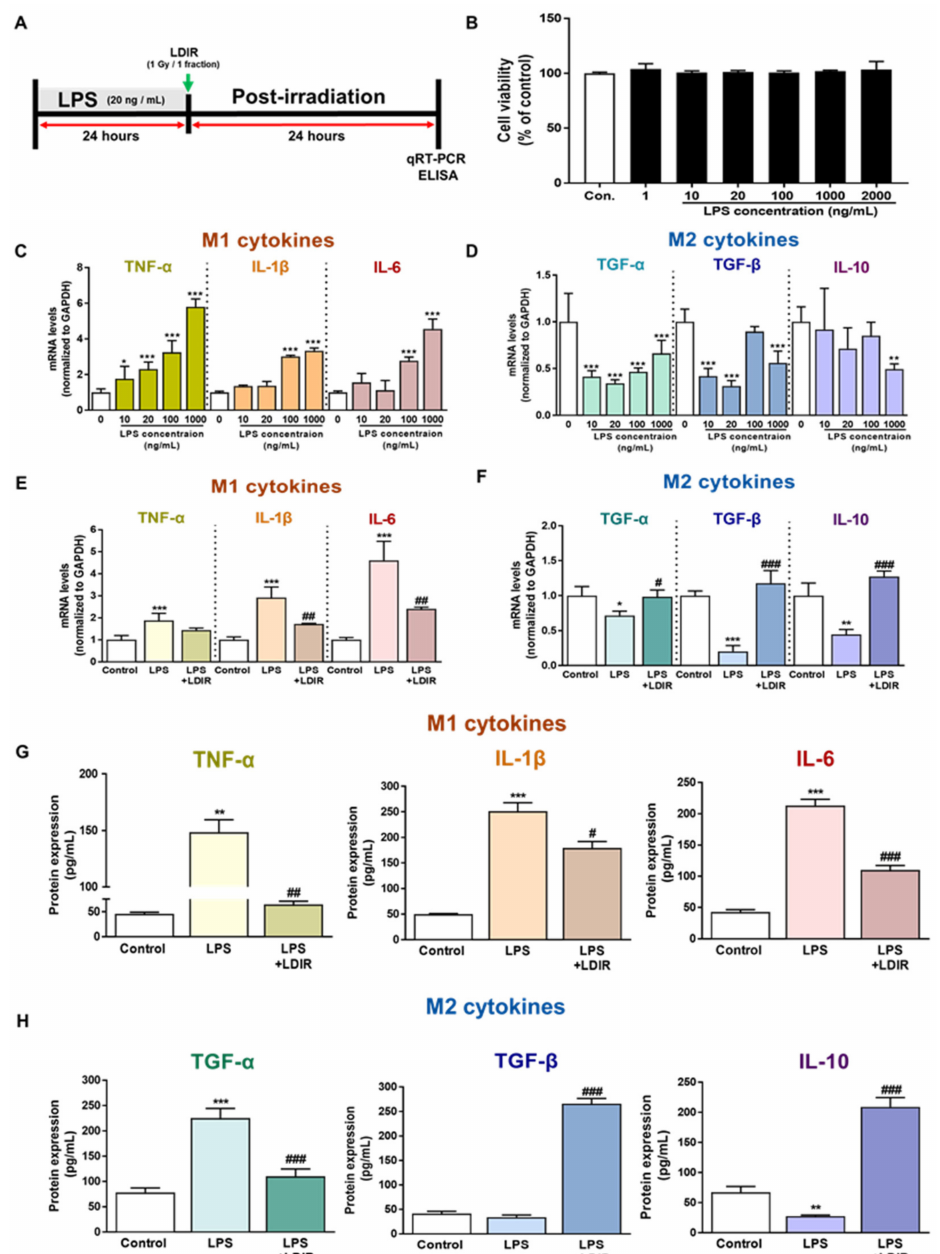
Figure 3. The modulatory e ff ects of LDIR on production and secretion of M1 cytokines (TNF- α , IL-1 β and IL-6) and M2 cytokines (TGF- α , TGF- β and IL-10) in lipopolysaccharide (LPS)-treated BV-2 cells. ( A ) Outline of the experimental design for in vitro assessment. ( B ) BV-2 cells were treated with LPS at doses of 1, 10, 20, 100, 1000 and 2000 ng / mL for 24 h. Cell viability was determined by the cell counting Kit-8 assay. ( C , D ) After BV-2 cells were treated with LPS (10, 20, 100, and 1000 ng / mL) for 24 h, the mRNA expression levels of M1 cytokines and M2 cytokines were measured by qRT-PCR. ( E – H ) BV-2 cells were treated with LPS (20 ng / mL) for 24 h, then exposed to LDIR (1 Gy / 1 fraction). The mRNA expression levels of ( E ) M1 cytokines and ( F ) M2 cytokines were measured by qRT-PCR. The protein levels of ( G ) M1 cytokines and ( H ) M2 cytokines in cultured media were measured by ELISA. * p < 0.05, ** p < 0.01, and *** p < 0.001 indicate significant di ff erences between the control and LPS-treated group. # p < 0.05, ## p < 0.01, and ### p < 0.001 indicate significant di ff erences between the LPS- and LPS + LDIR- treated group. Data are presented as mean ± SD from triplicate